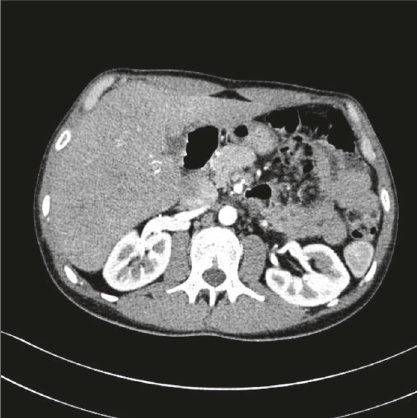
Figure 1: CT scan shows an aspecific thickening of jejunum with partial contrastographic enhancement near the left colon, with a modestdilatationofthelumenofsmallbowelupstreamoftheinjury.